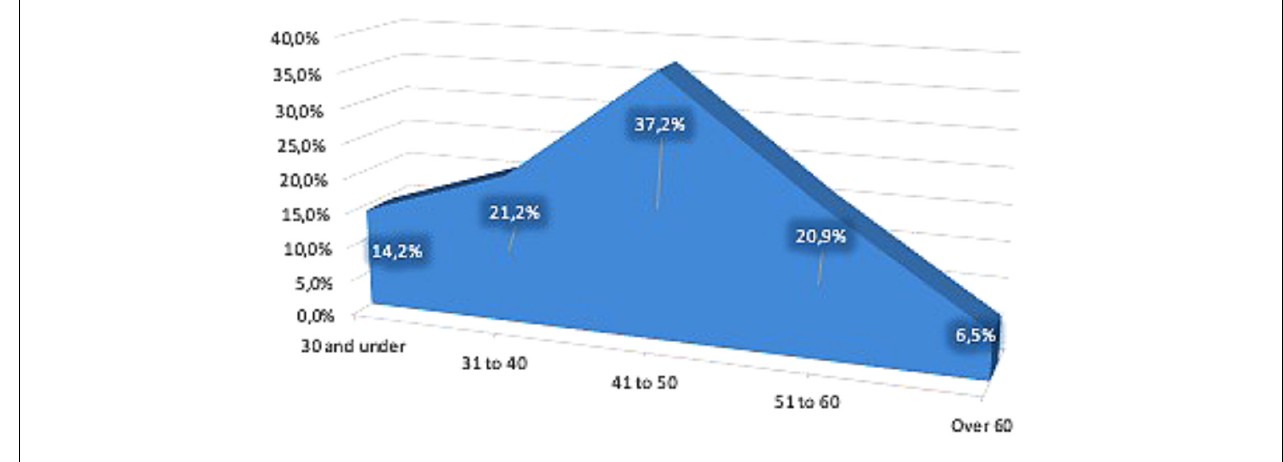
FIGURE 2 | Sample distribution by age.